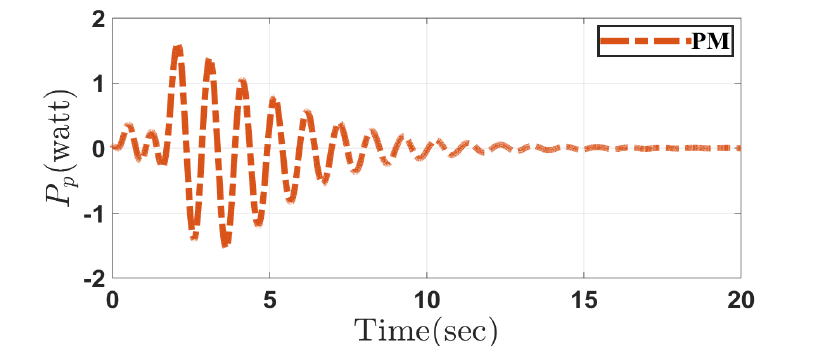
Figure 10. Input power of movable mechanism in the proposed method (PM) in Case